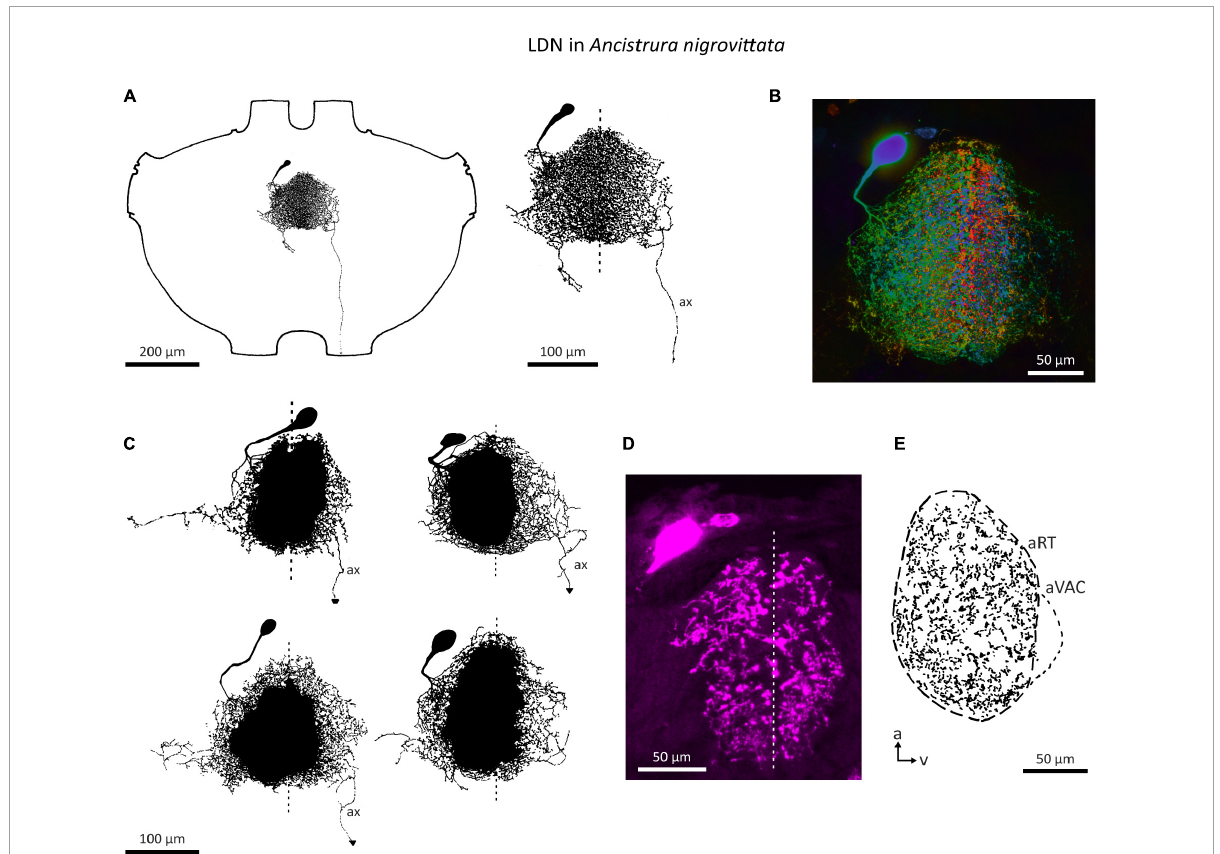
FIGURE9 Morphology of the local neuron LDN in A. nigrovittata . (A) Wholemount and detailed view of LDN in a male. (B) Color coded (warm = dorsal, cold = ventral) maximum projection of a confocal stack of LDN filled with neurobiotin and developed with streptavidin-Cy3 in a female. (C) Four examples of the main branches in two males (upper) and two females (lower). A dashed line indicates the ganglion midline. (D,E) Sections (10 µ m) of LDN in a female (D) and a male (E) . (D) Confocal image of a transversal section showing the similarity of branches in both hemiganglia. (E) Drawing of a parasagittal section showing the arborizations in the auditory neuropile. a, anterior; aRT, anterior ring tract; aVAC, anterior ventral associations center; ax, axon-like branch; v, ventral.